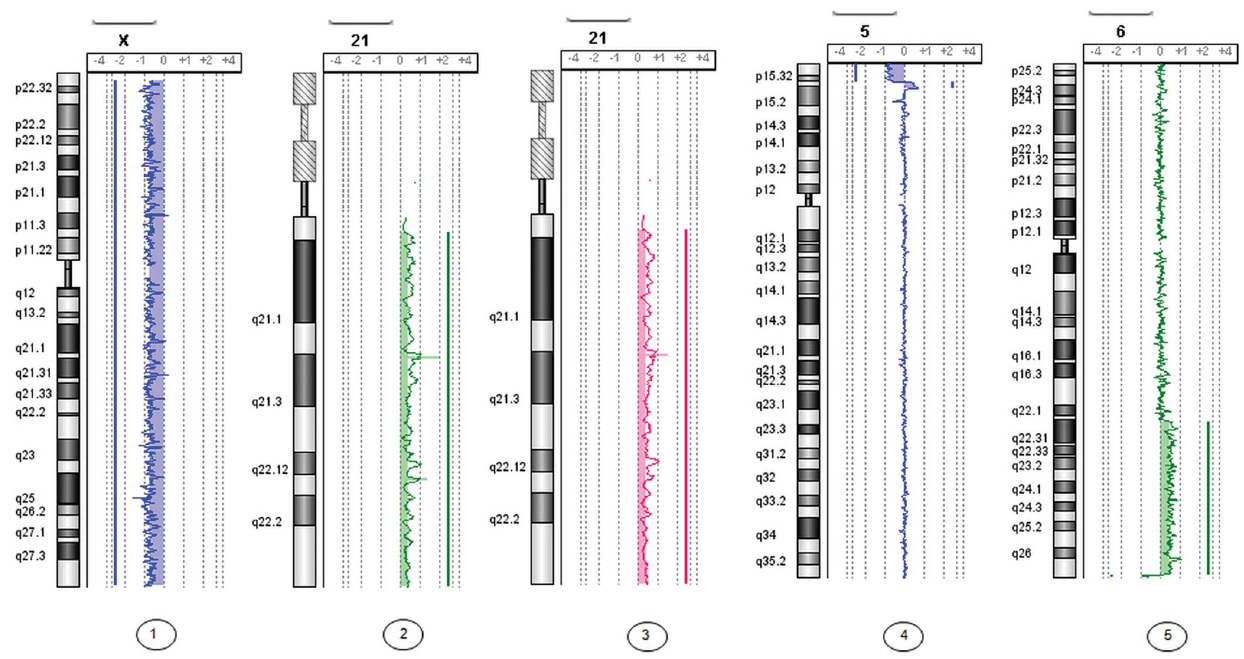
Figure 1. Genome views of five number and structural abnormalities characterized by array-CGH, extracted from 1 ml of uncultured amniotic fluid from patients at less than 16 weeks of gestation. (cases 1 to